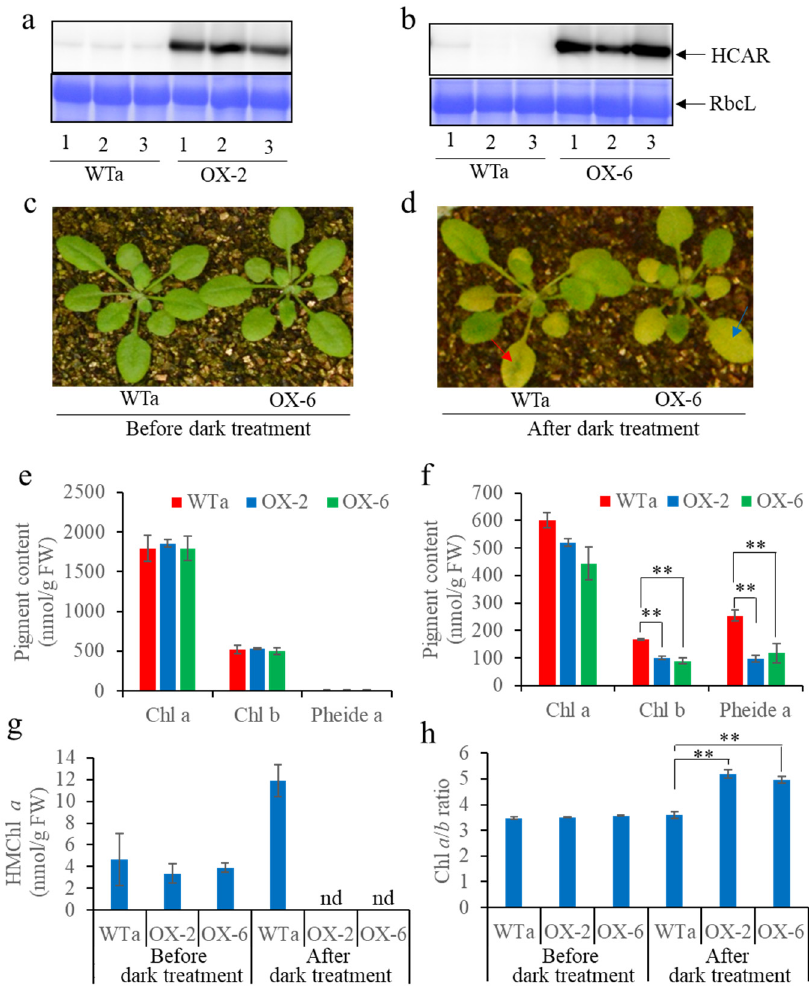
Figure 4. Phenotypic and Chl metabolic characterization of HCAR-OX and WT plants during dark-induced senescence. ( a , b ) HCAR protein abundance in WTa and HCAR-OX lines. Total leaf protein was separated by SDS-PAGE and subjected to immunoblot analysis with anti-AtHCAR antiserum. ( c , d ) Phenotype of HCAR-OX lines and WT plants before and after seven days of dark treatment. Red arrow indicates the “green island” symptoms of WT plants. The blue arrow indicates leaf senescence without “green island” symptoms of the HCAR-OX lines. ( e , f ) Chl and Pheide a content of No. 5–6 leaves before and after intact plant incubation in darkness. ( g , h ) HMChl a content and Chl a / b ratio of leaves No. 5–6 before and after intact plant incubation in darkness. Error bars indicate the SDs of three biological replicates. Asterisks indicate significant differences compared to BCG (Student’s t -test, ** p < 0.01). nd indicates the pigments content was not detected.